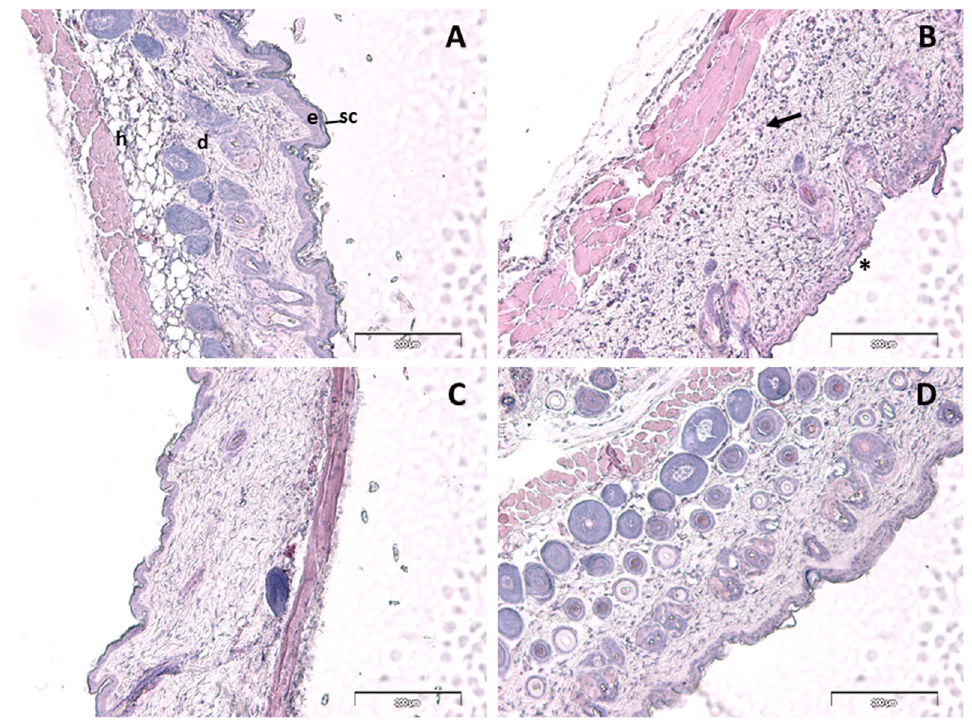
Figure 5. Hematoxylin and eosin staining of control ( A ), m -Xylene ( B ), PGZ-limonene ( C ), and limonene ( D ) mice’s back skin from affected area ( × 10 magnification). Hematoxylin stains nuclei blue/black, and eosin stains keratin and cytoplasm red/orange. Bars = 200 µ m. sc = stratum corneum, e = epidermis, d = dermis, h = subcutaneous layer Arrow = leucocyte infiltrate, * = loss of stratum corneum.